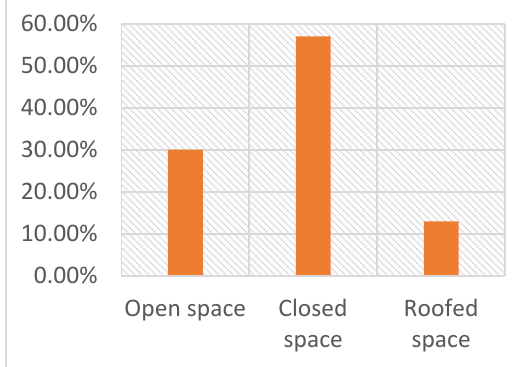
Fig. 6: The share of open, closed, and roofed spaces in the structure in selected contemporary mosques